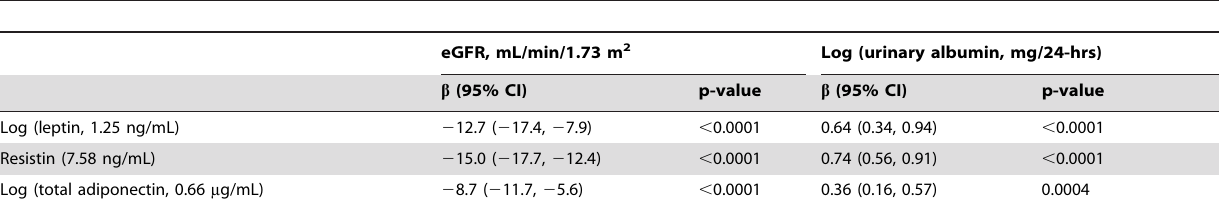
Table 4. Multivariable-adjusted regression coefficients (95% confidence intervals) of GFR and urinary albumin associated with a one standard deviation difference in